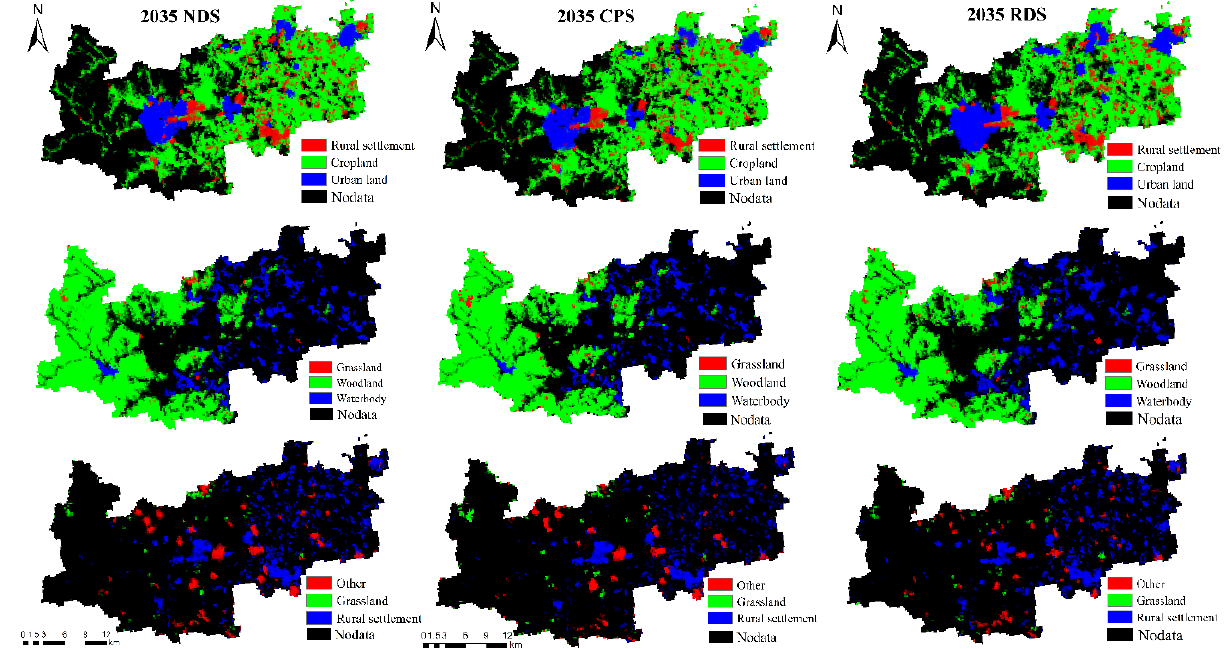
Figure 6. Map showing land use layout under different scenarios.